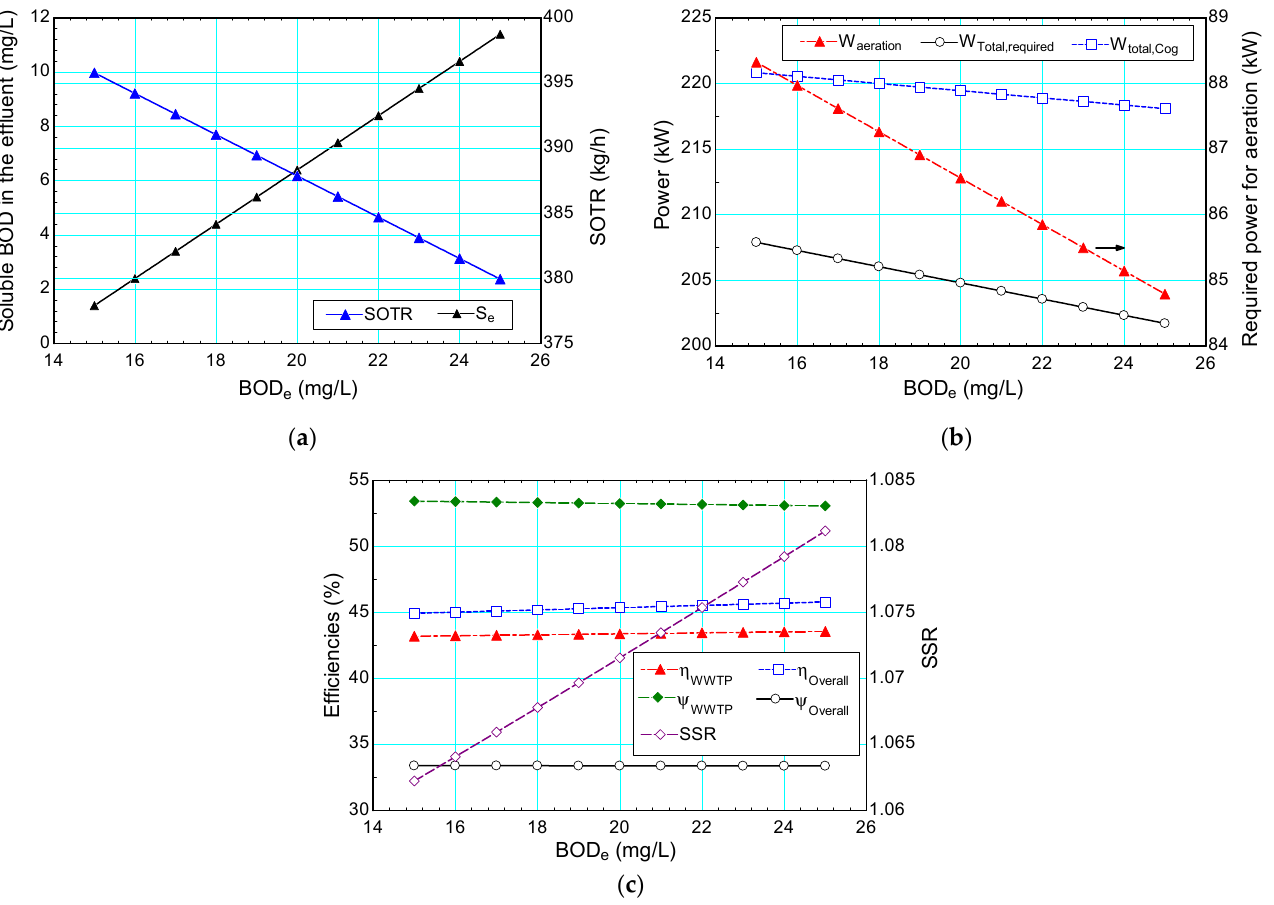
Figure 3. BOD effect on: ( a ) Soluble BOD in the effluent and SOTR, ( b ) Efficiencies, ( c ) Power requirement and power production.